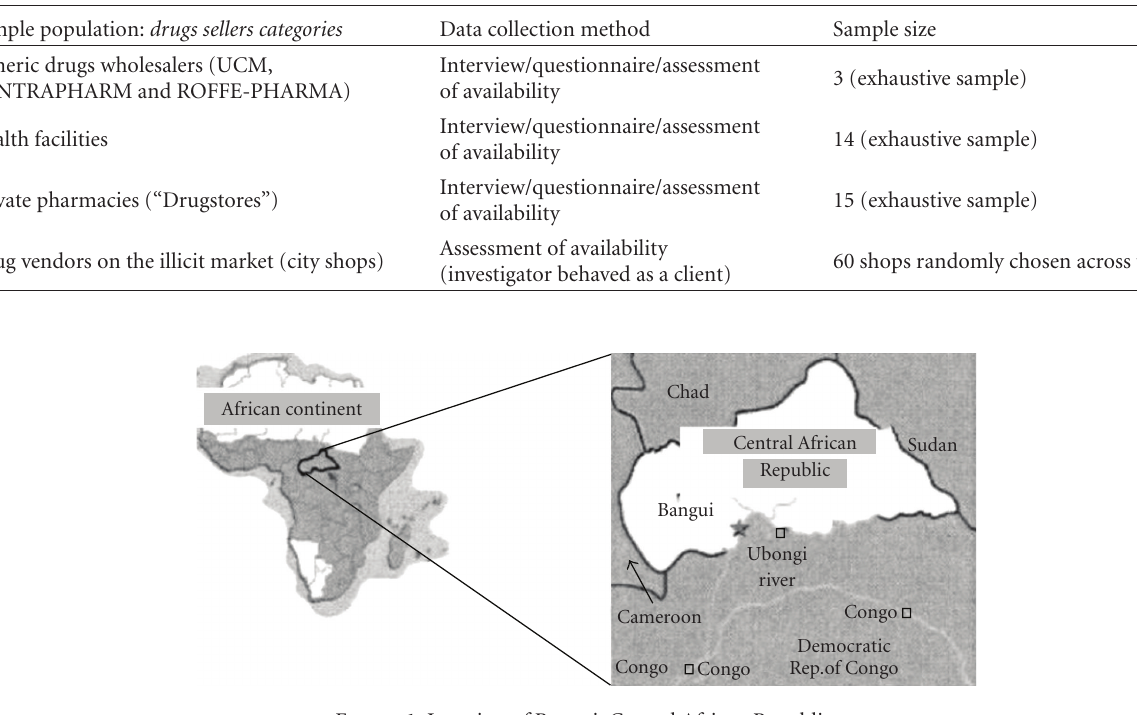
Figure 1: Location of Bangui, Central African